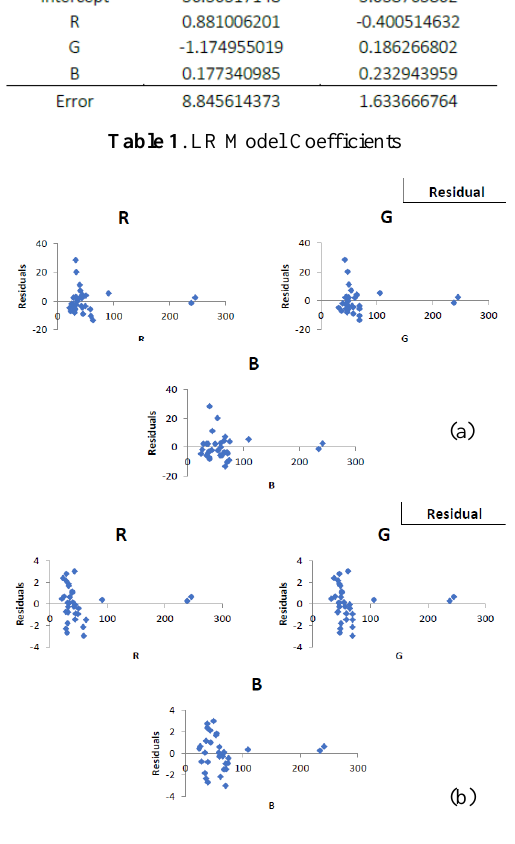
Figure 6 . Residuals (a) Chlorophyll and (b) Dissolved Oxygen